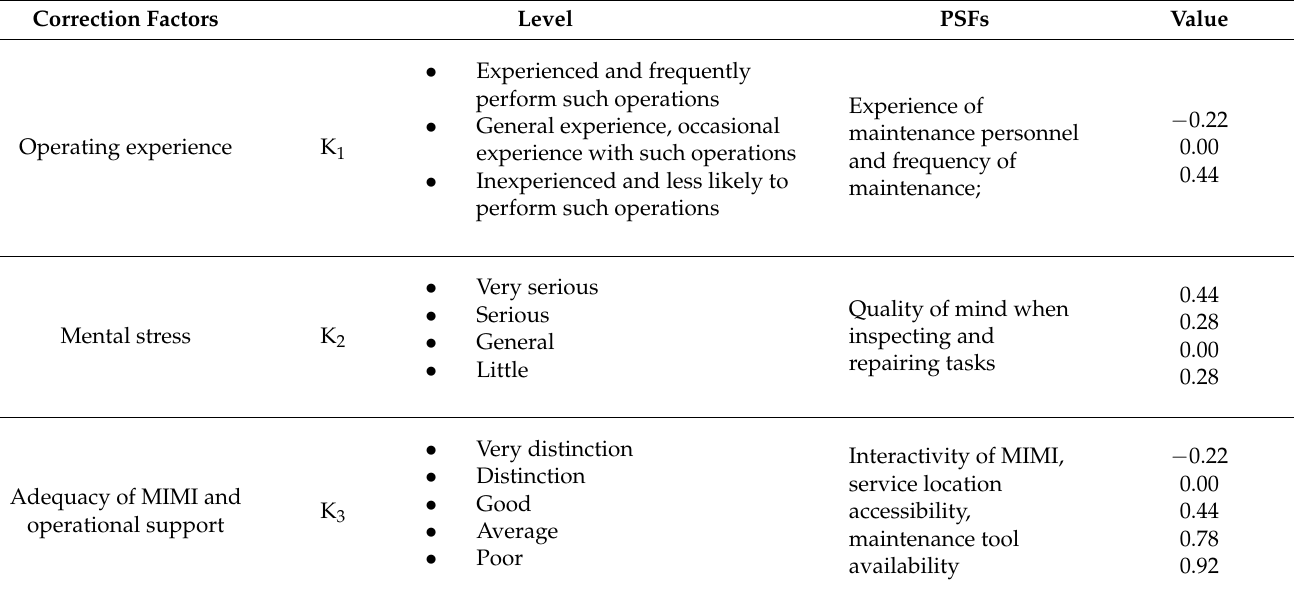
Table 4. HCR method correction factors with PSFs of cabin